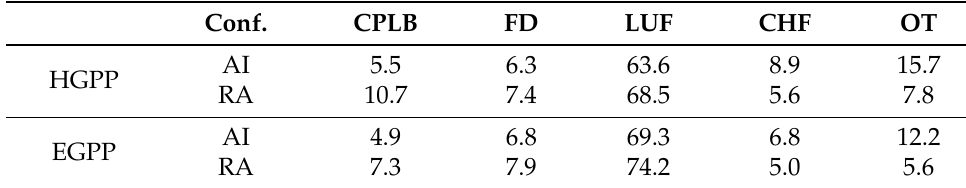
Table 6. Average processing times (in %) for each deblocking filter block profiled over the HGPP and EGPP.